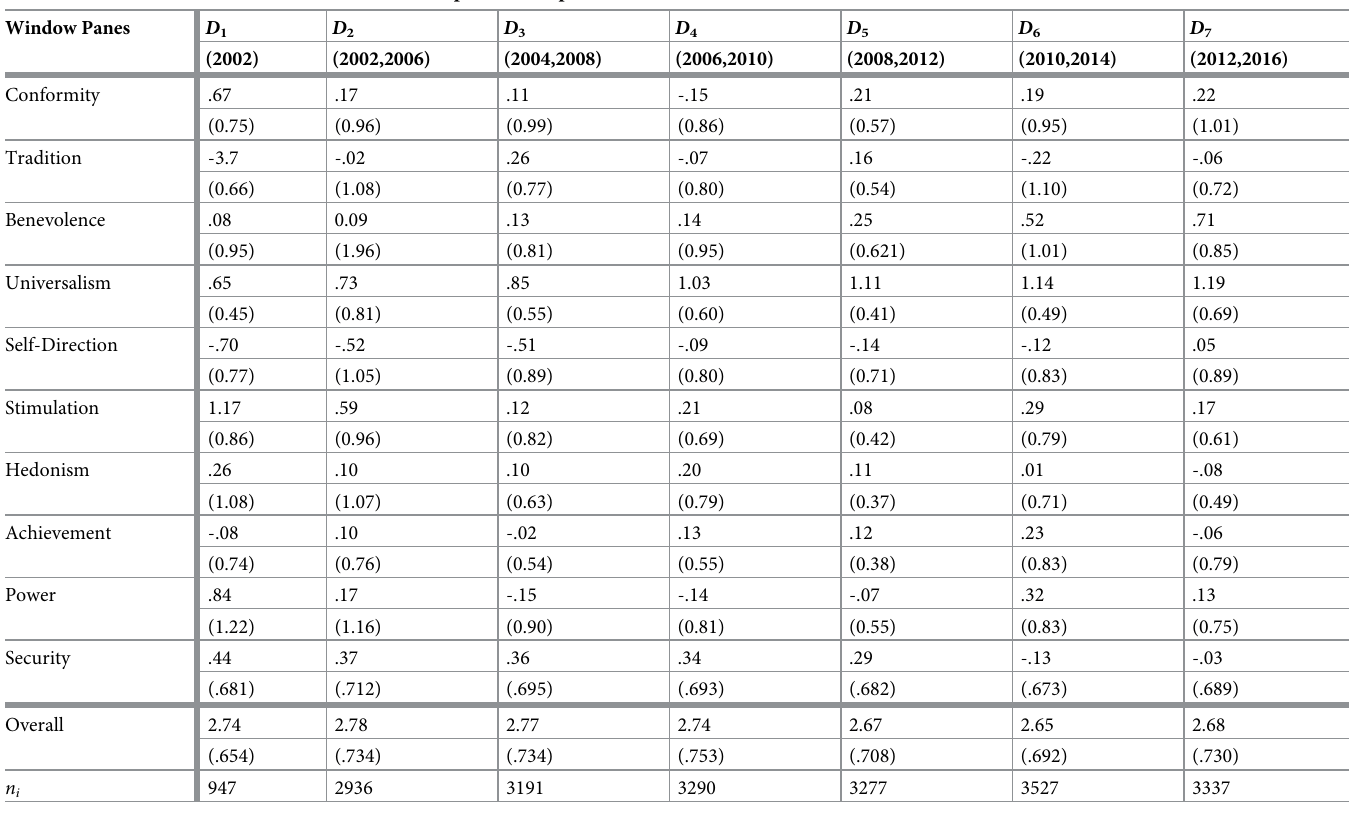
Table 3. Values scores and MART for cluster C 12 at respective time